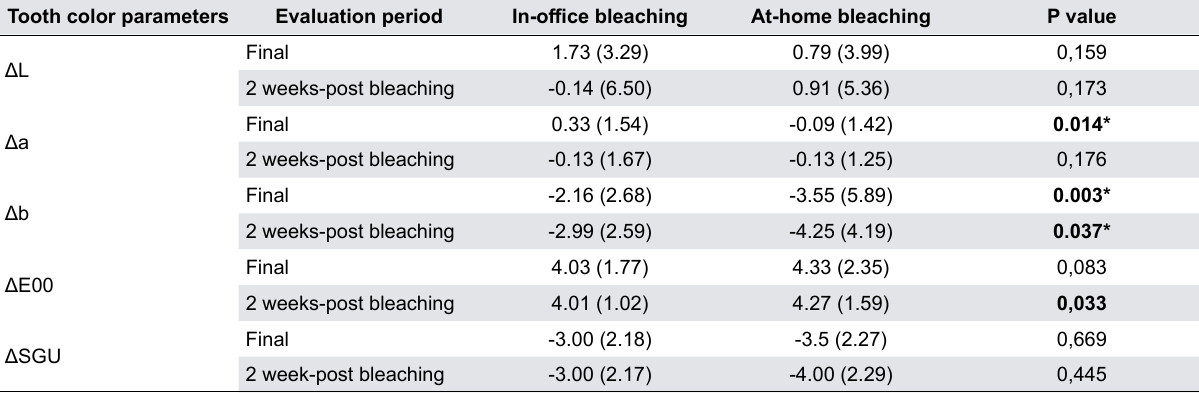
Table 3- Comparison of in-office and at-home bleaching by different color coordinates of CIEL*a*b* system, ΔE00 and Tooth color parameters